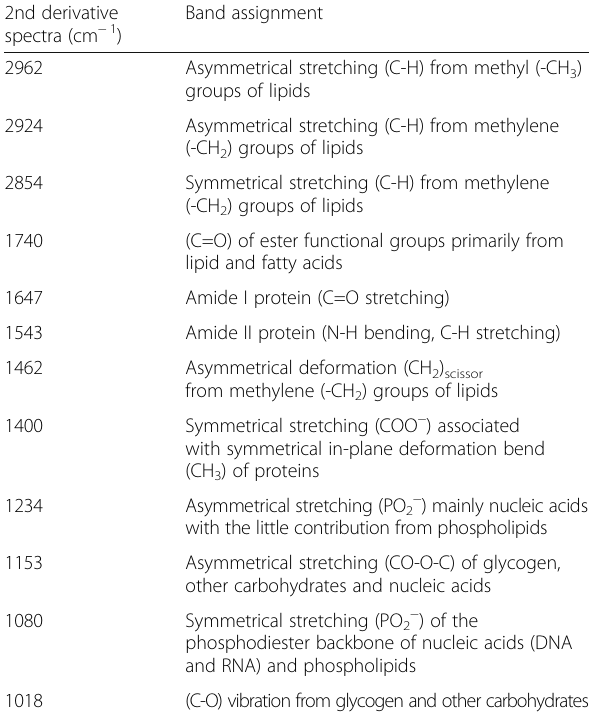
The second derivative spectra in the protein region